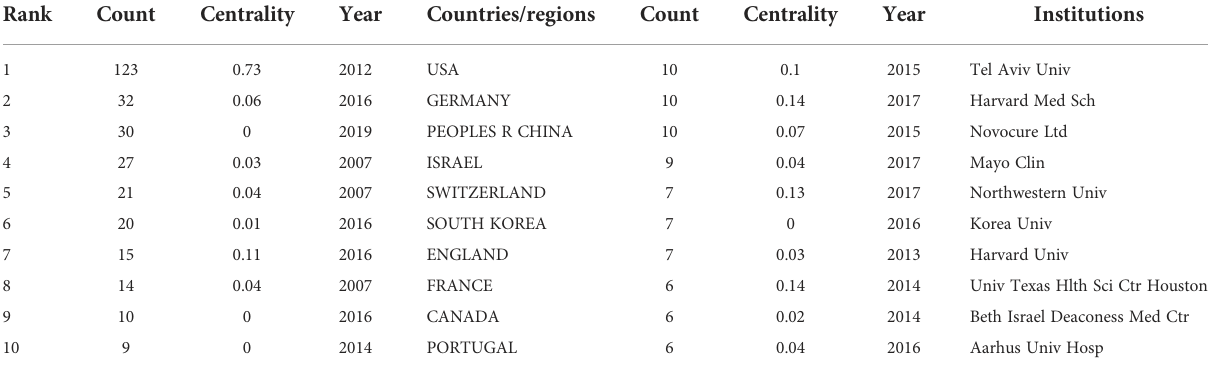
TABLE 1 Top 10 countries/regions and institutions for related publications from 2007 to September